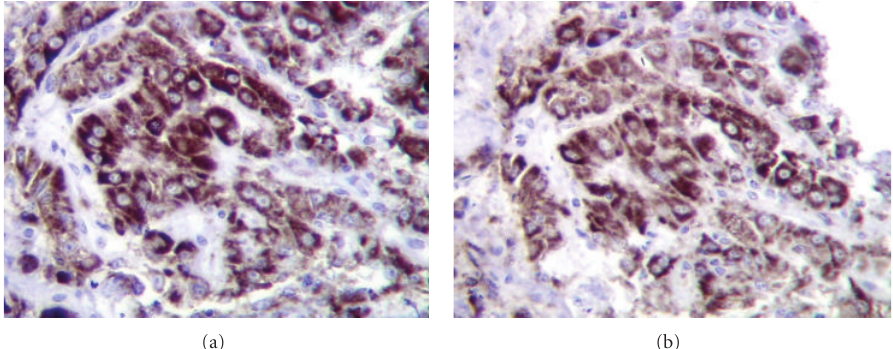
Figure 2: Immunohistochemistry showing expression of Heppar 1 and CD34 on the tumor biopsy: (a) expression of Heppar 1 (magnification × 400) and (b) expression of CD34 (magnification × 400).